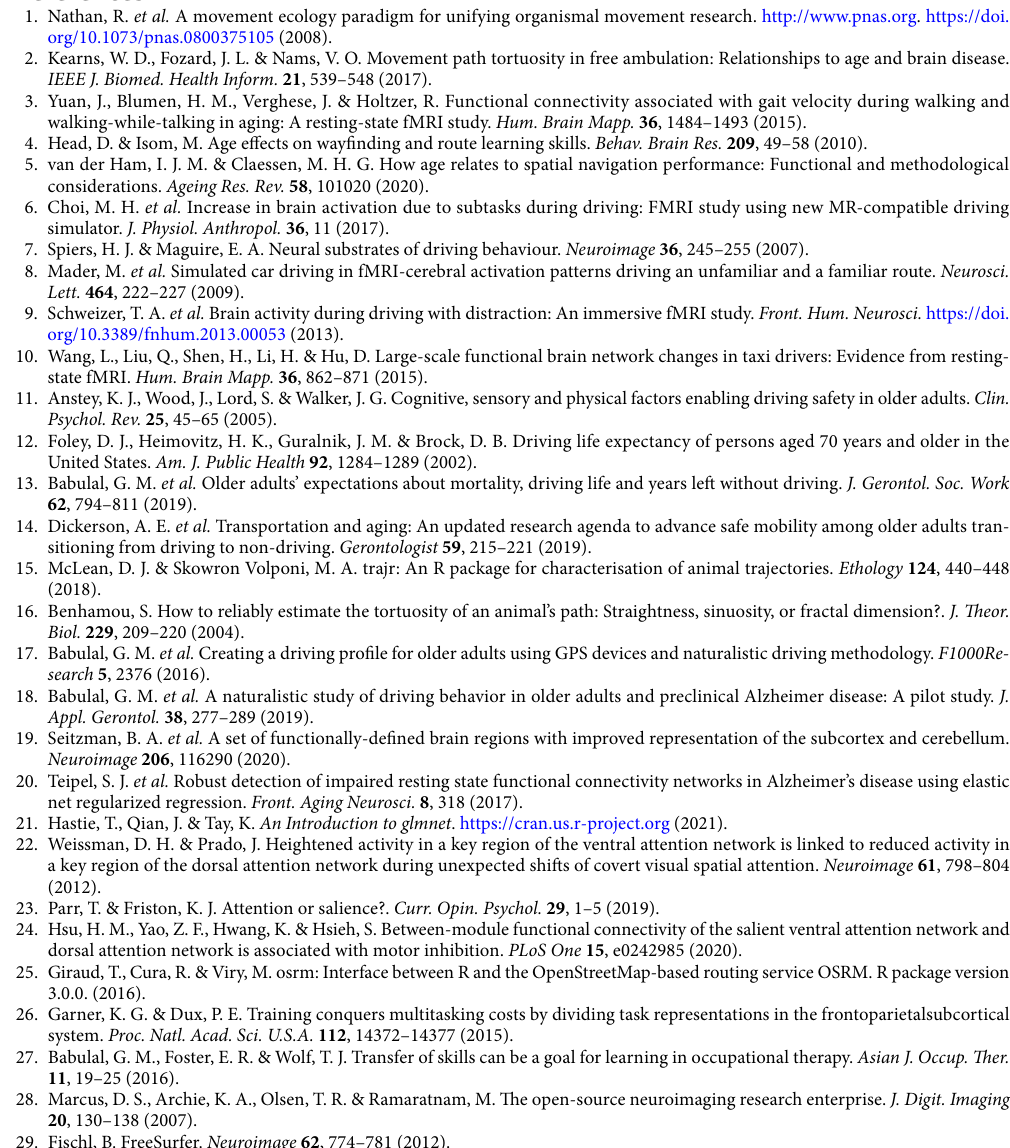
Figure 2. ( A ) Route straightness was calculated by taking the Haversine distance (shown in red) divided by the actual route (shown in black) distance. This figure was generated using Open Street Maps data, available under Creative Commons License 2.0 (https:// www. opens treet map. org/ copyr ight; Figure generated 2022 Jan 18) and the R packages osrm and mapsf. ( B ) The actual–optimal distance ratio was calculated by dividing the length of the actual route (shown in black) divided by the optimal route (shown in red). The actual route driven was estimated using the coordinates from each 30 s epoch breadcrumbs from the ODB-II chip. The optimal route was generated via Open Street Maps (https:// www. opens treet map. org/ copyr ight; Figure generated 2022 Jan 18). For this example, the actual route driven was six miles, while the optimal proposed route was four miles. The actual–optimal distance ratio for this particular route was 1.5. ( C ) The networks most frequently utilized for prediction of the median straightness index were the intranetwork ventral attention network connection (VAN × VAN) and the salience–dorsal attention network connection (SAL × DAN). ( D ) The network most frequently utilized for prediction of the median actual–optimal distance ratio was the frontoparietal–subcortical (FP × SubCort) network connection. ( E ) There was a positive correlation between the VAN × VAN connection and median route straightness. ( F ) There was a positive correlation between the SAL × DAN connection and median route straightness. ( G ) There was a positive correlation between the FP × SubCort connection and the median actual–optimal distance